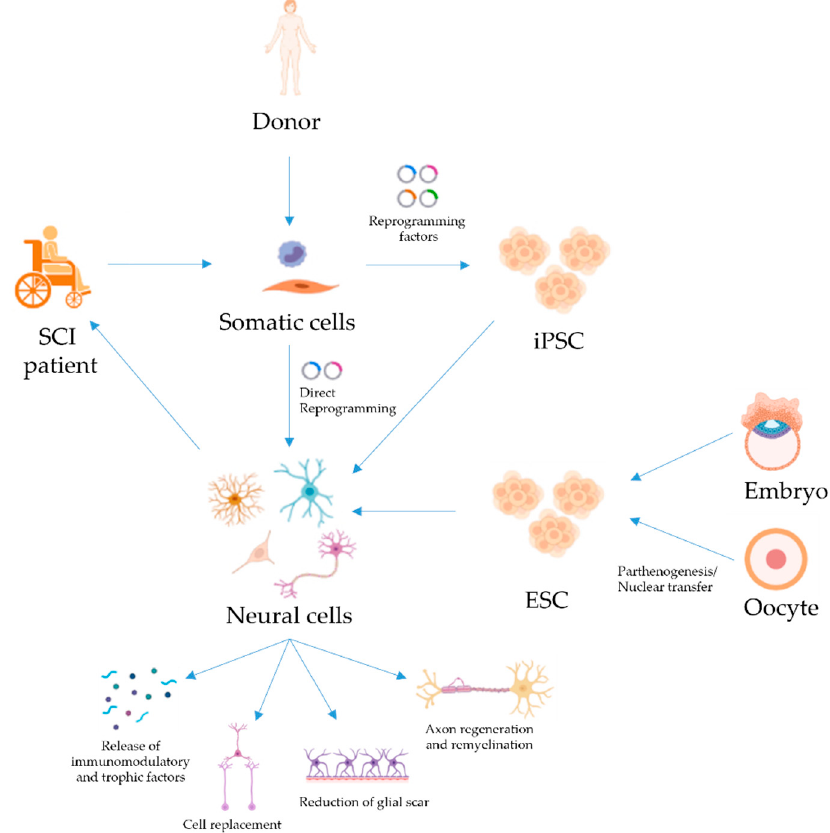
Figure 1. Treatments of SCI with pluripotent and reprogrammed cells. Patient- or donor-derived somatic cells can be reprogrammed into iPSC, which can then be differentiated into neural cells for transplantation to restore function in patients with SCI. PSC derived from embryos or oocytes are an alternative source of neural cells for therapy. Direct reprogramming of somatic cells to neural cells (without passing through a pluripotent state) has also been achieved and could be used for SCI treatment. Several mechanisms for neural cell-mediated repair have been suggested, such as cell replacement, the release of immunomodulatory and trophic factors, regeneration and remyelination of axons, and/or reduction of glial scarring. Created with BioRender.com (last accessed on 15 November 2021).